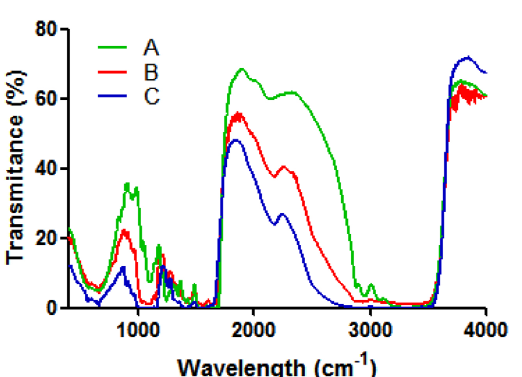
FIGURE 3 - DSC curves of gelatin/chitosan/PEG mixture (A)